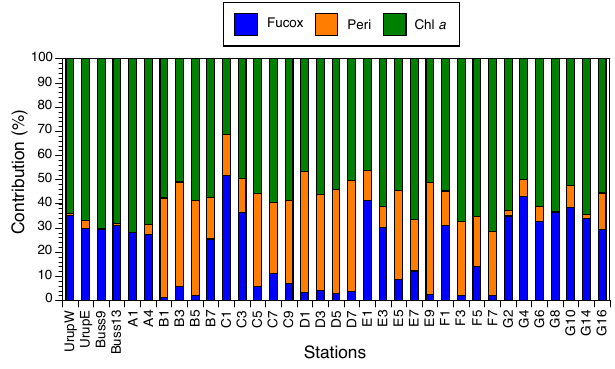
Fig. 9 ! Fig. 9. Relative levels (%) of fucoxanthin (Fucox), peridinin (Peri),